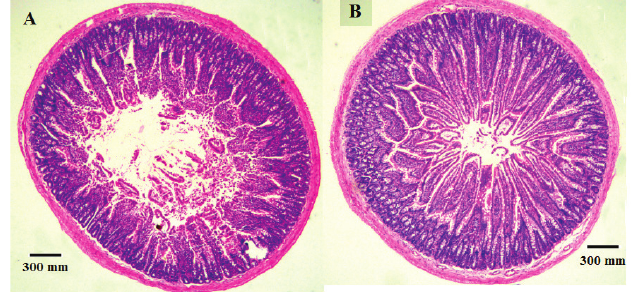
FIGURE 7 - The effect of PG on the jejunum morphology of weaned rats. Note: A: control group; B: PG group. In the Figure 7A, the box and ellipse areas pointed by the arrow were the inflammatory areas. Correspondingly, no inflammatory area was detected in the Figure 7B after feeding